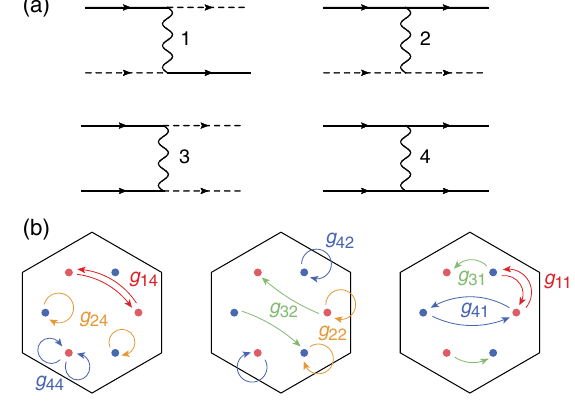
FIG. 2. (a) Diagrammatic representation of scattering proc- esses. The four diagrams describe the change of either saddle point or valley index, where solid and dashed lines correspond to electron propagators with different indices. (b) Nine momentum- conserving scattering processes out of 16 distinct scattering processes g . Hexagons are the Brillouin zone boundaries and ij the dots are located at saddle points with two colors correspond- ing to the two valleys. There are three types in the interactions (from left to right): intravalley, intervalley density, and intervalley exchange